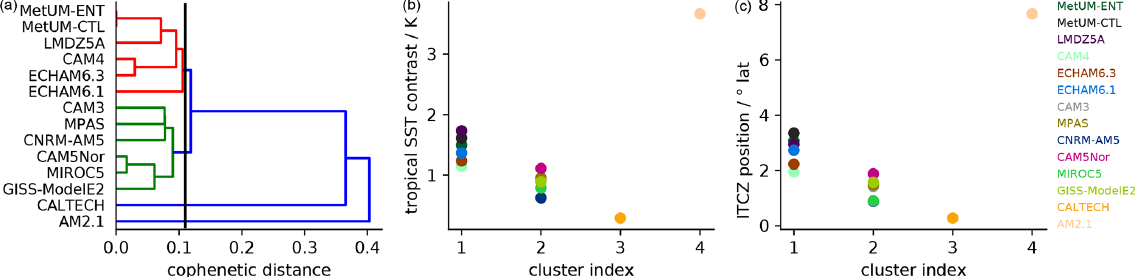
Figure 3. Model clustering of the AquaControl global networks (a) along with the tropical SST contrast (b) and ITCZ position (c) for the four identified clusters. (a) The dendrogram obtained from the clustering of the zonal-mean network measures. The vertical line indicates the level of cophenetic distance at which we split the models into four clusters.